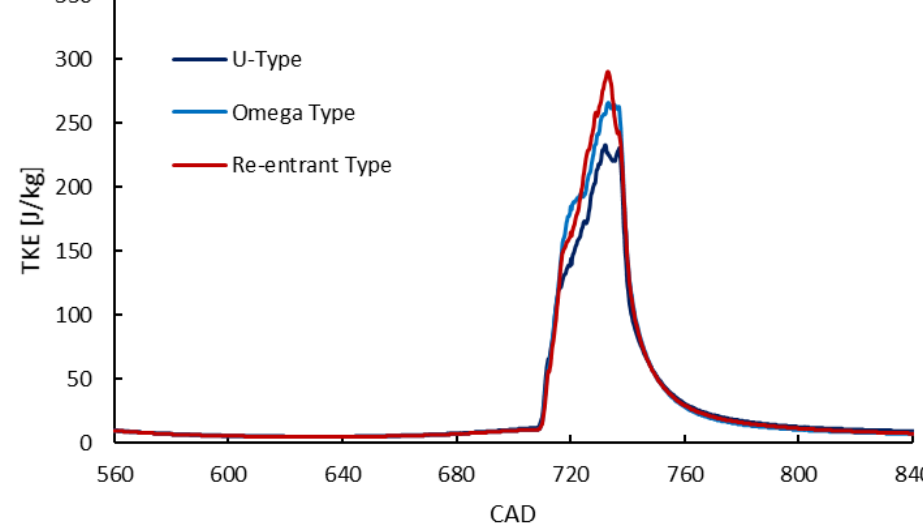
Figure 6. Mean TKEs of the in-cylinder fluid flows.